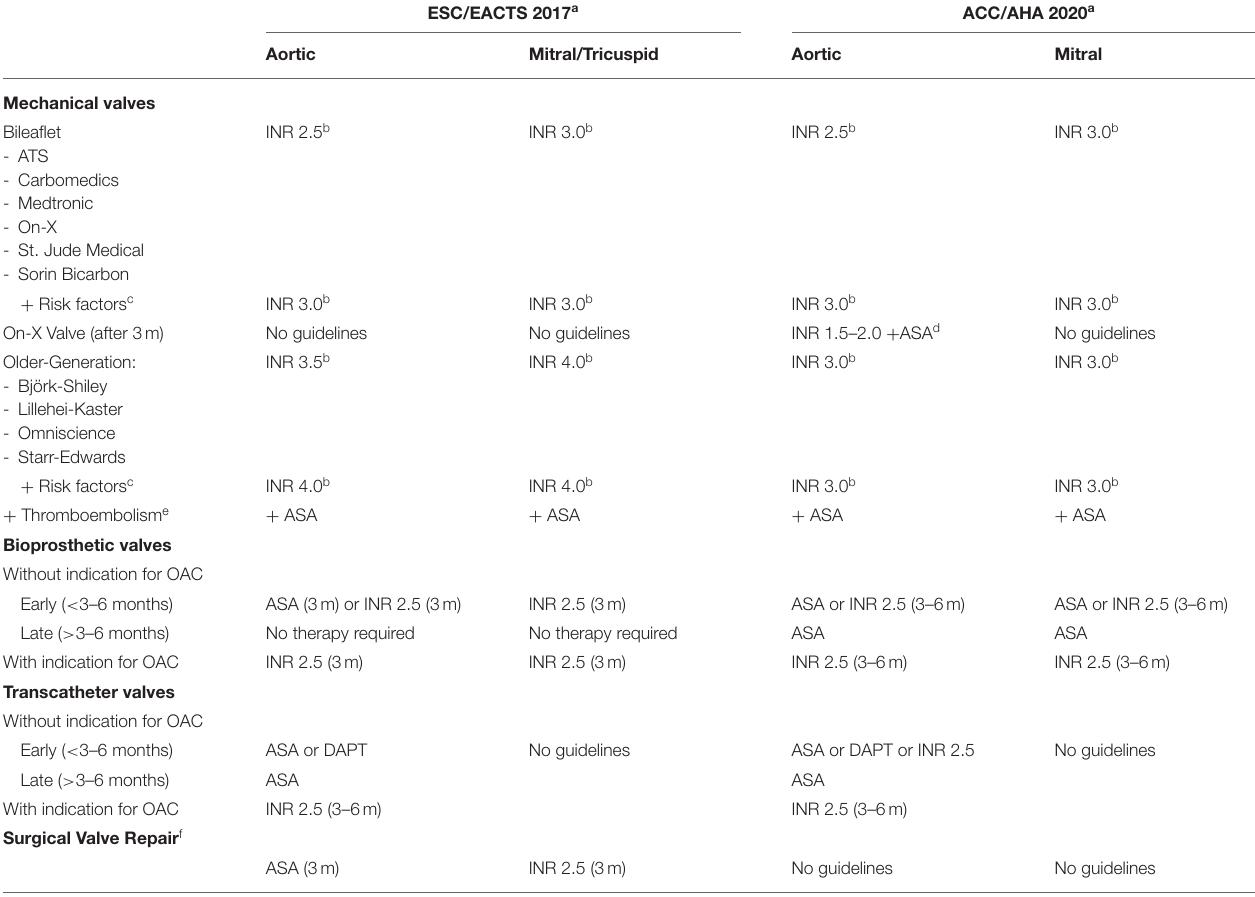
TABLE 1 | Overview and comparison of 2017 ESC/EACTS and 2020 ACC/AHA guidelines for the management of valvular heart